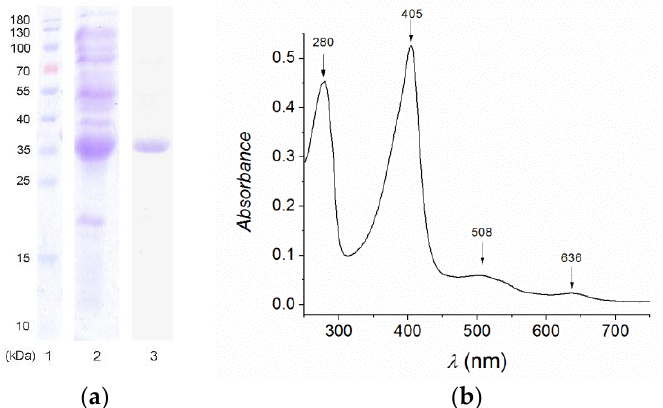
Figure 1. ( a ) SDS PAGE analysis. Lane 1: Molecular markers; lane 2: Cell free extract; lane 3: Pf DyP B2 fraction after purification with Nuvia aPrime 4A chromatography. ( b ) UV-Vis spectrum of Pf DyP B2.